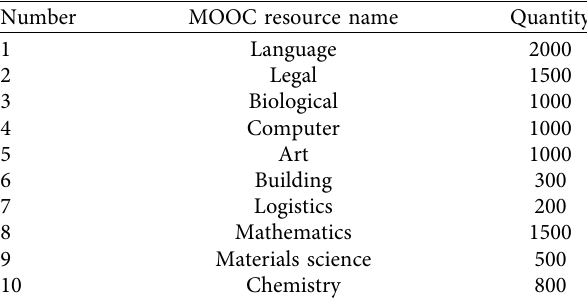
Table 1: Quantity distribution of MOOC